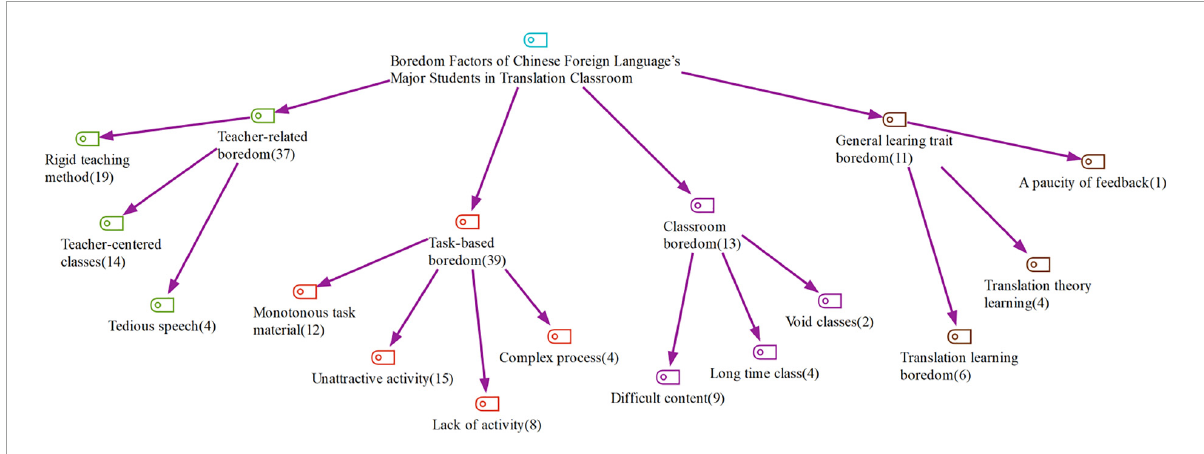
FIGURE3 Perceptions of boredom in the translation